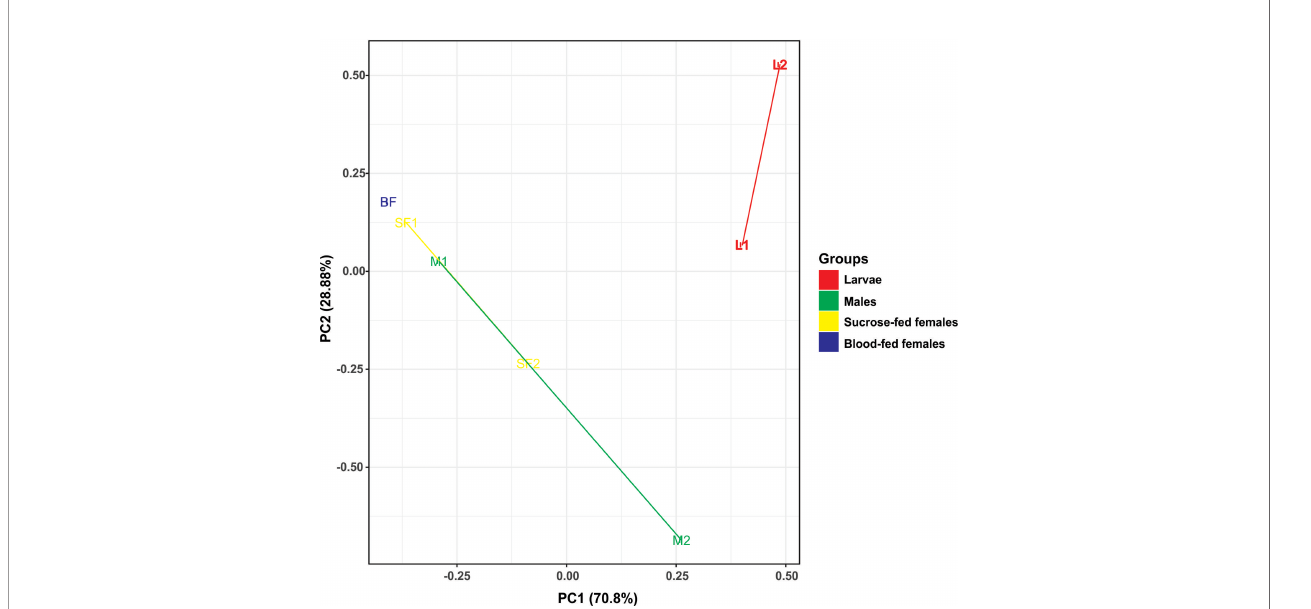
FIGURE 3 | Principal component analysis (PCA) based on the Euclidean distances for fungal communities from samples along the Cx. quinquefasciatus development. There are two distinct groups, adults and larvae, using two principal components (PC1 and